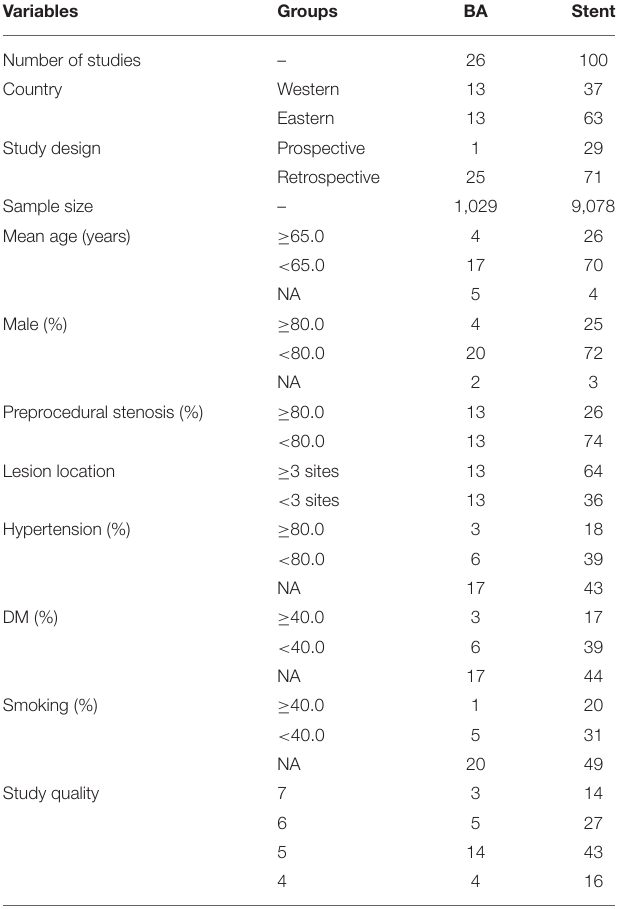
BA, balloon angioplasty; DM, diabetes mellitus. TIA The incidence of TIA after balloon angioplasty and stenting was reported in 4 and 33 studies, respectively ( Supplementary Material ). The pooled incidence of TIA after balloon angioplasty and stenting was 3% (95%CI: 0–6%) and 4% (95%CI: 3–5%), respectively, and no significant difference between balloon angioplasty and stenting for the risk of TIA was observed (RI: 0.75; 95%CI: 0.01–58.53; P = 0.897; Figure 2 ). Sensitivity analyses indicated the incidence of pooled TIA after balloon angioplasty ranged from 2.0 to 5.0%, while after stenting ranged from 3.4 to 3.9% ( Supplementary Material ).